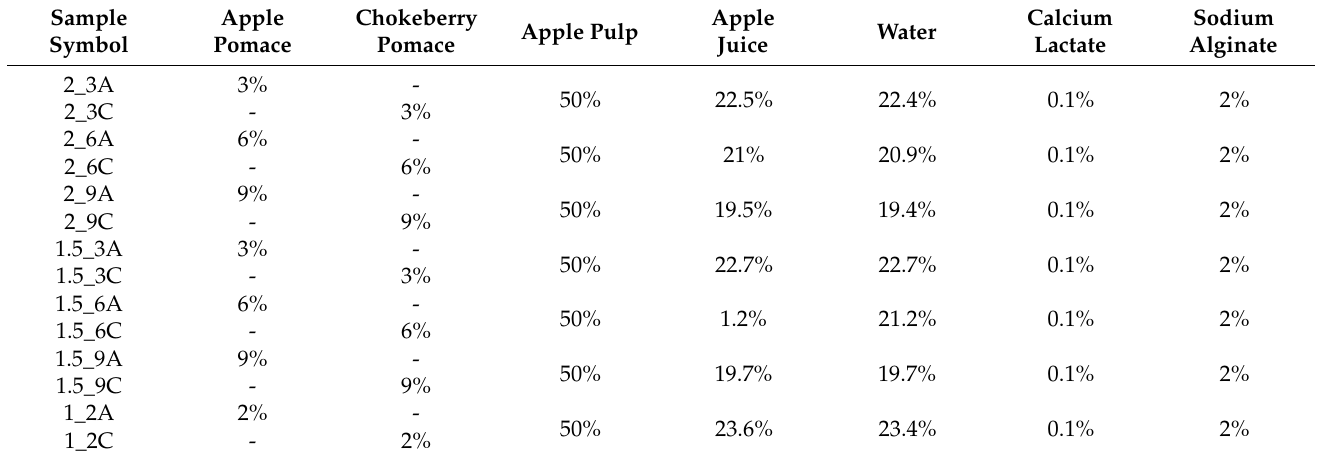
Table 2. The effect of hydrocolloid and pomace addition amount on the dry matter content and water activity of freeze-dried fruit bars with apple or chokeberry pomace and water content of samples before freeze-drying. Denotations in Table 1 include. Index (A) next to the sample symbol—bars with the apple pomace, Index (C) next to the sample symbol—bars with the chokeberry pomace. Mean values marked with the same index letter (a–e, A–F) do not differ statistically significantly at the level of p = 0.05. The small index letter (a–e) indicates the statistical analysis results for samples with apple pomace whereas the big index letter (A–F) indicates the statistical analysis results for samples with chokeberry